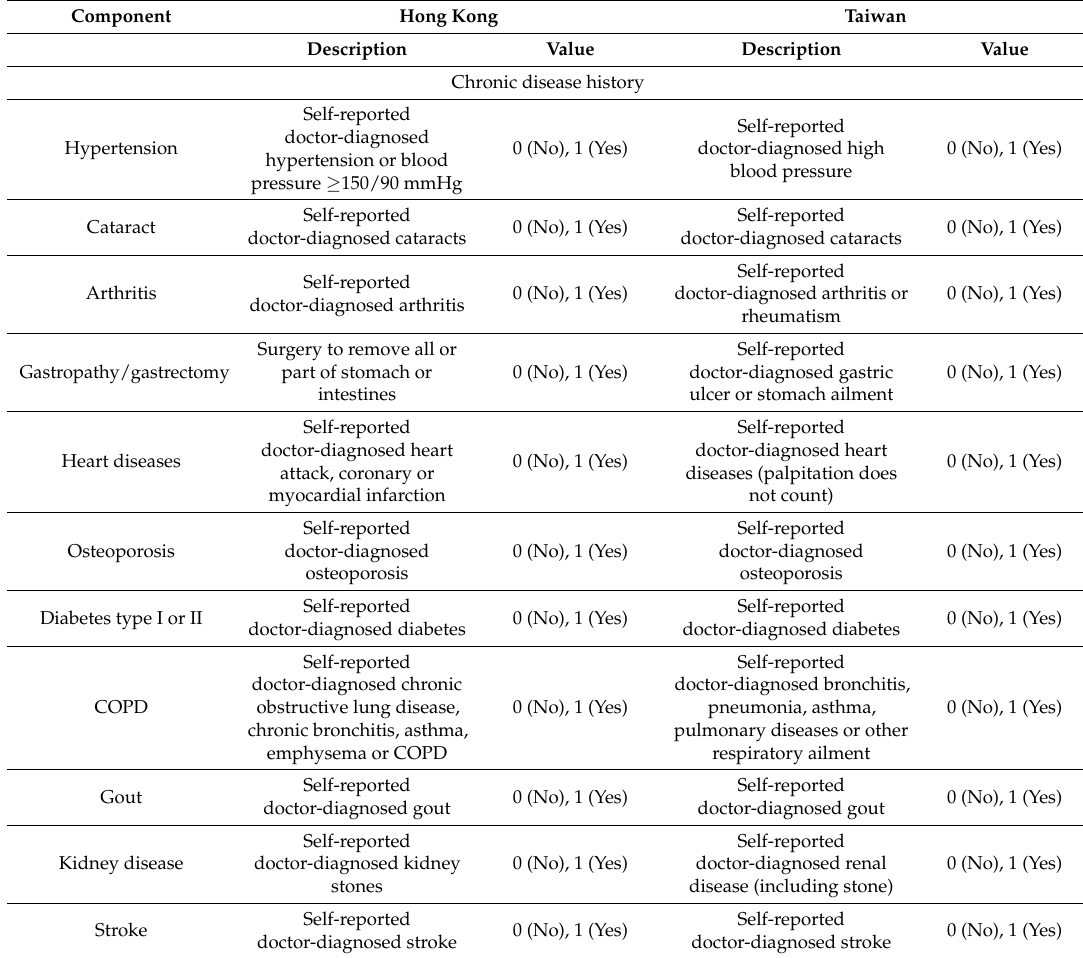
Table A1. Calculation of the frailty